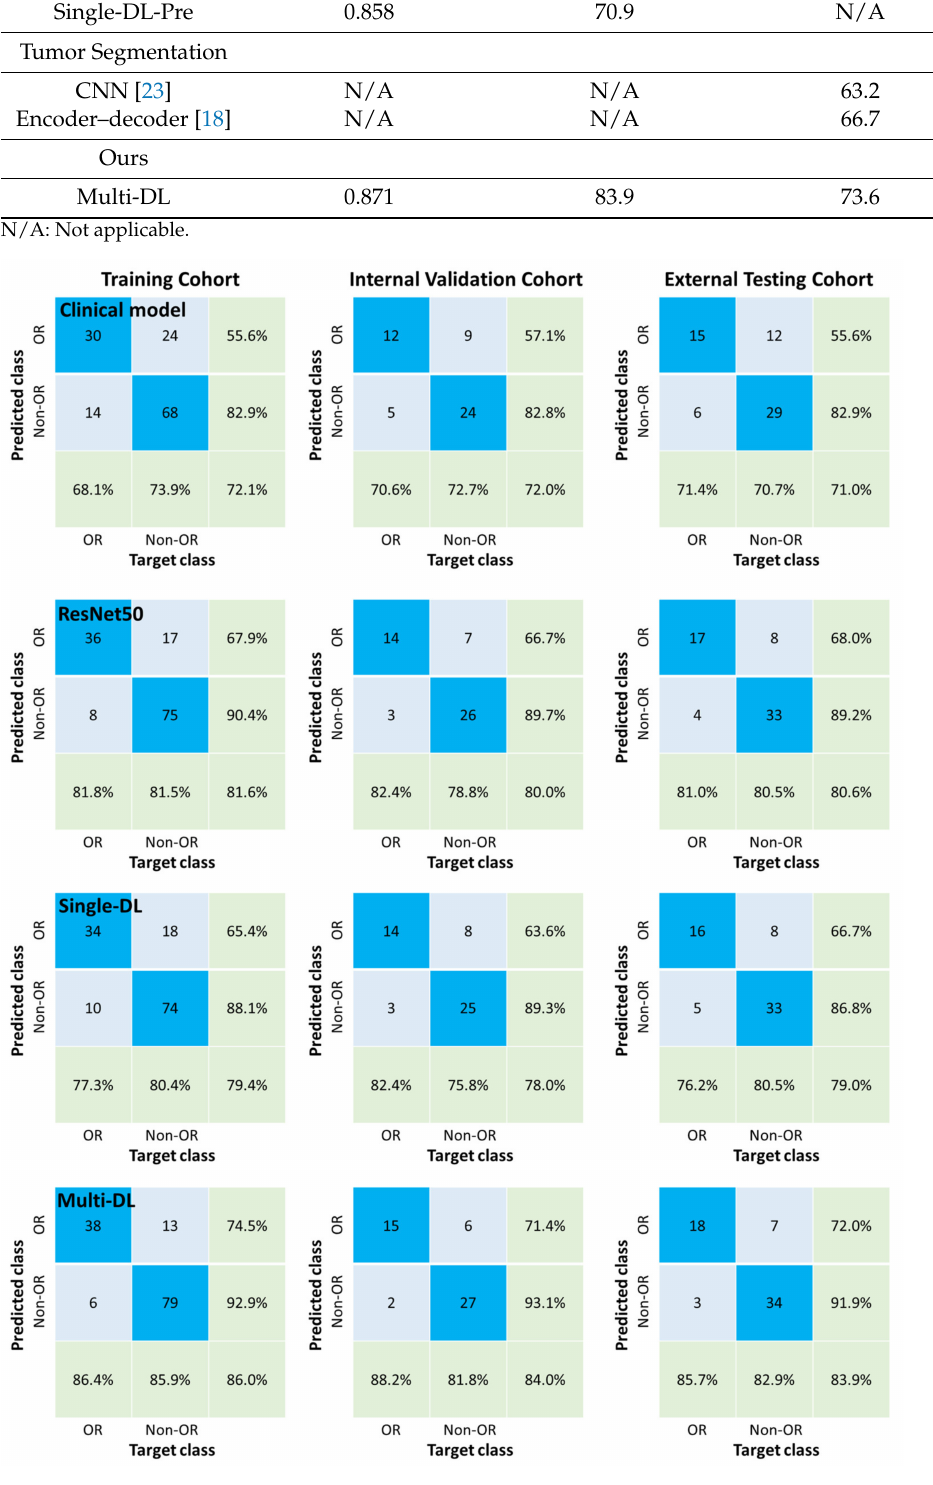
Figure 5. The confusion matrix for the clinical model, ResNet50, single-DL and multi-DL